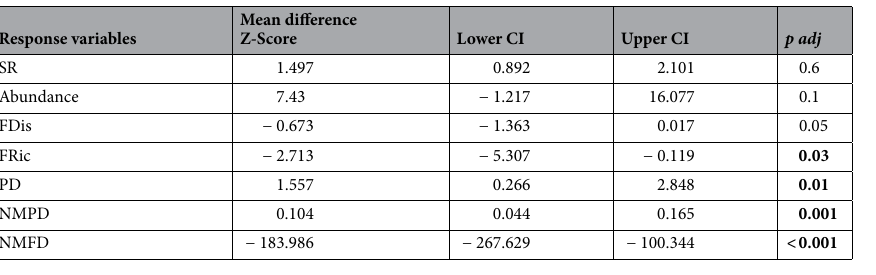
Table 1. Results of t-test for the differences in five native diversity metrics between non-invaded and invaded plots (mean and 95% confidence intervals, CI). SR is the number of native species within each plot, Abundance is the number of individuals, FDis is the functional dispersion, FRic is the functional richness, PD is the faith’s phylogenetic diversity, NMPD, NMFD is the native phylogenetic and functional relatedness respectively. p -values were adjusted following Bonferroni approach, significant adjusted p-values are in boldface type.